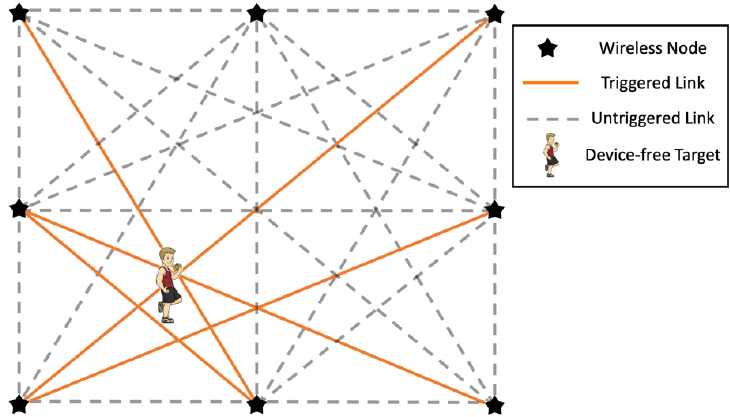
Figure 1. Device-free localization (DFL) system made up of eight nodes.